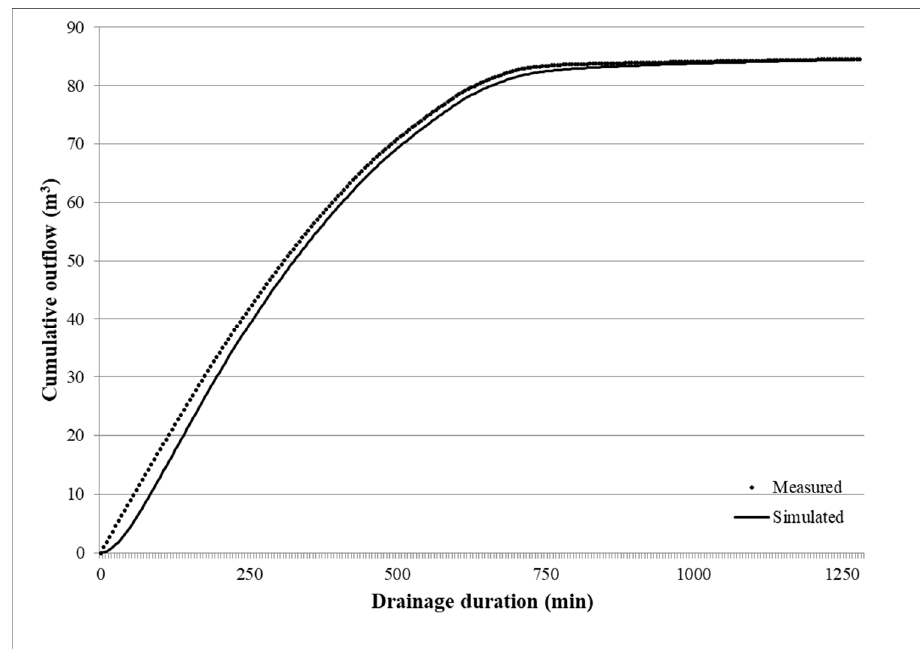
Figure 4. Observed and simulated cumulative outflow curves during the drainage experiment.